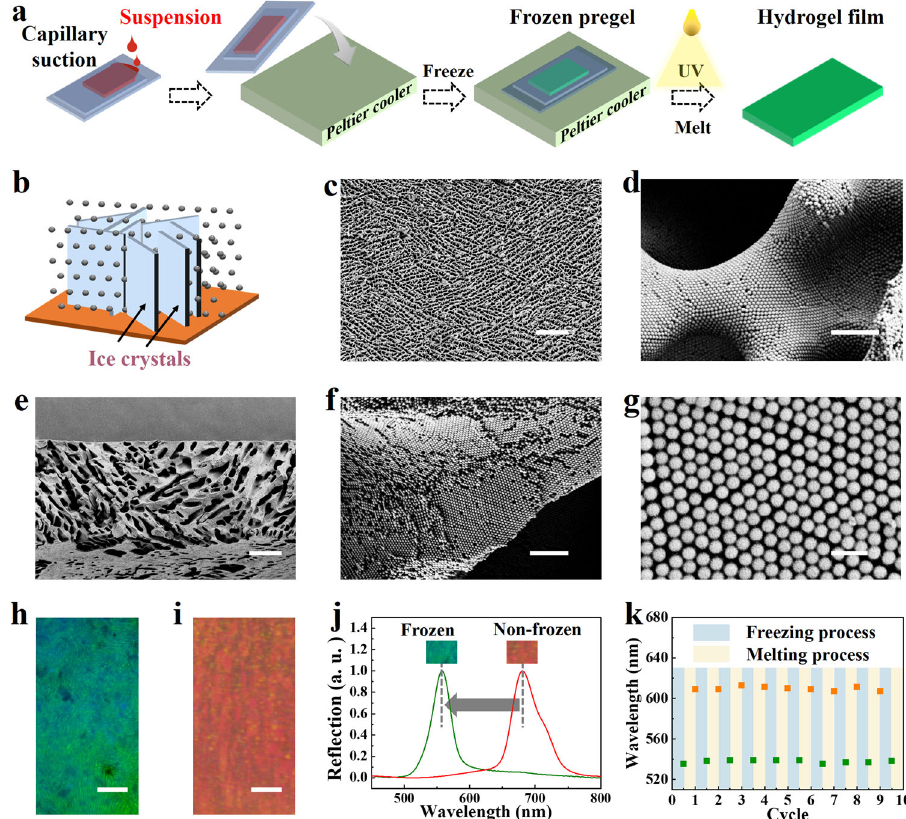
Fig. 2 Optical and morphological characterization. a Schematic illustration of freezing pregel suspension on a uniform substrate. b Schematic illustration of nanoparticles assembly process based on ice-templating technology. c , d The surface of II-TSCHF. e – g The cross section of the fi lm. h , i The optical images of structural color hydrogel fi lms; ( h ) the II-TSCHF that was freeze-photopolymerized; ( i ) the hydrogel fi lm that was photopolymerized directly without being frozen. The freezing temperature was − 7.9 °C. The v/v ratio of H 2 O/PEGDA was 3:1. Nanoparticles with a diameter of 172 nm were employed. j Re fl ection spectra corresponding to the hydrogel fi lms in ( h , i ). k The pregel suspension was cyclically frozen and melted at a constant temperature between − 5.9 °C and ~20 °C. The v/v ratio of H 2 O/PEGDA was 1:1. Nanoparticles with a diameter of 172 nm were employed. The scale bars are 100 μ m in ( c , e ), 2 μ m in ( d , f ), 500 nm in ( g ), and 500 μ m in ( h , i